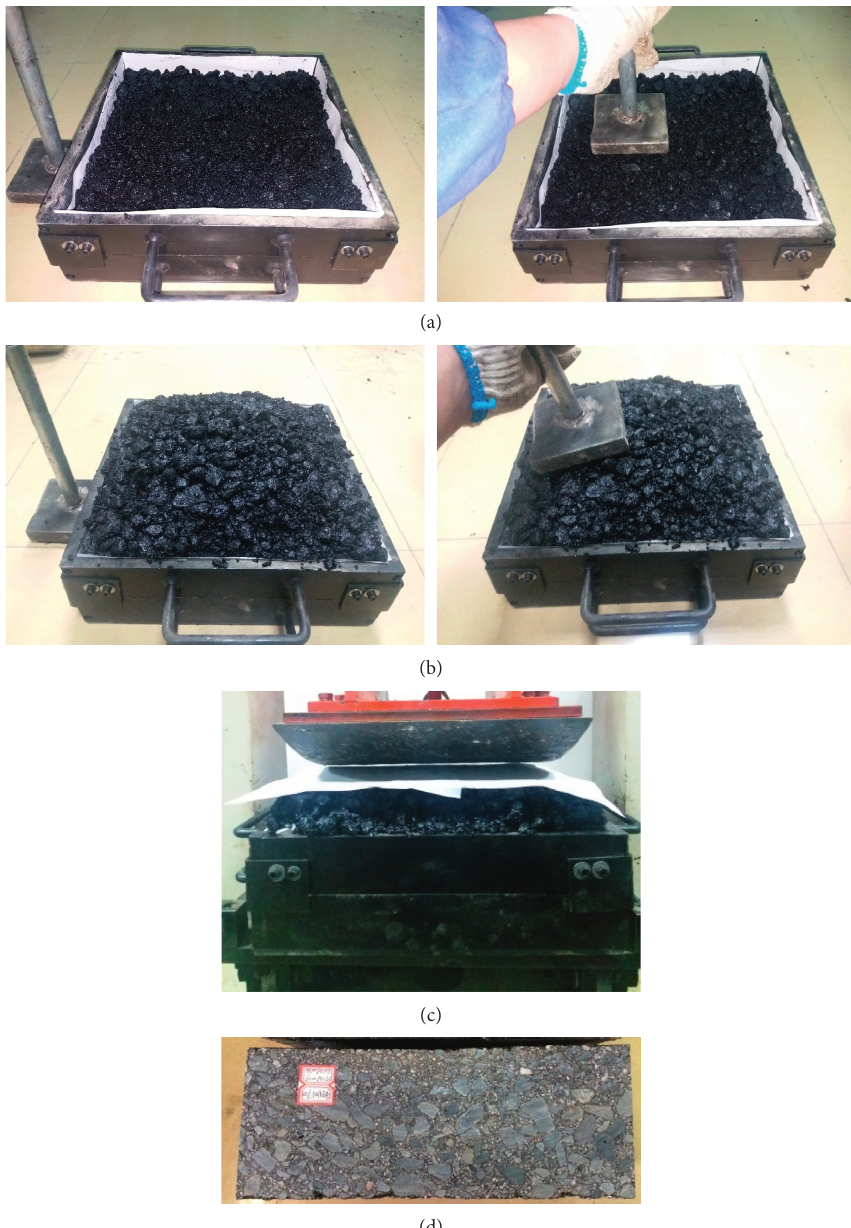
Figure 2: Double-layer paved beam test specimen preparation process. (a) Spreading the bottom layer mixtures and original compaction. (b) Spread the surface layer mixtures. (c) Compaction by rolling compaction machine. (d) Double-layer paved beam test